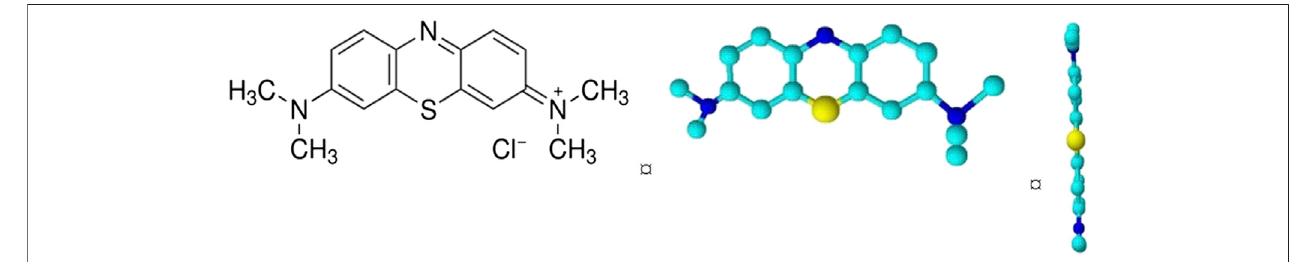
FIGURE 2 | Molecular structure of MB (Basic Blue